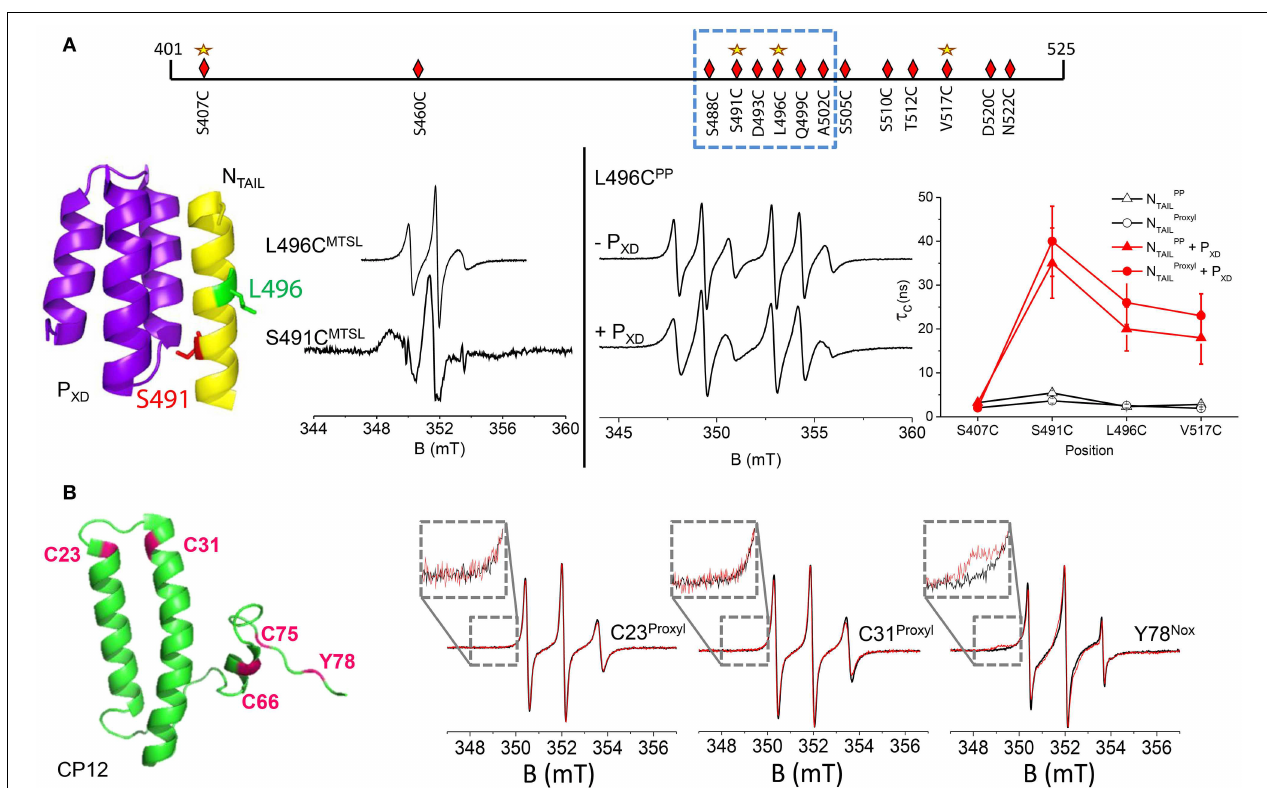
FIGURE 2 | (A) upper panel: schematic representation of positions targeted for cysteine substitution and spin labeling of N TAIL (aa 401–525) with MSTL spin label (diamonds) and PP spin label (stars). The dotted frame indicates the region that undergoes an induced folding in the presence of the partner protein P XD . Left panel: Illustration of two EPR spectral shapes obtained in two positions of the MTSL within the induced folding region of N TAIL : positions 491 and 496. These two positions are highlighted in the crystal structure of the chimera construct between P XD and the N TAIL region encompassing residues 486–504 (pdb code 1T60). Right panel: EPR spectra of the phosphorylated proxyl grafted at position 496 in the absence and in the presence of P XD . Variation